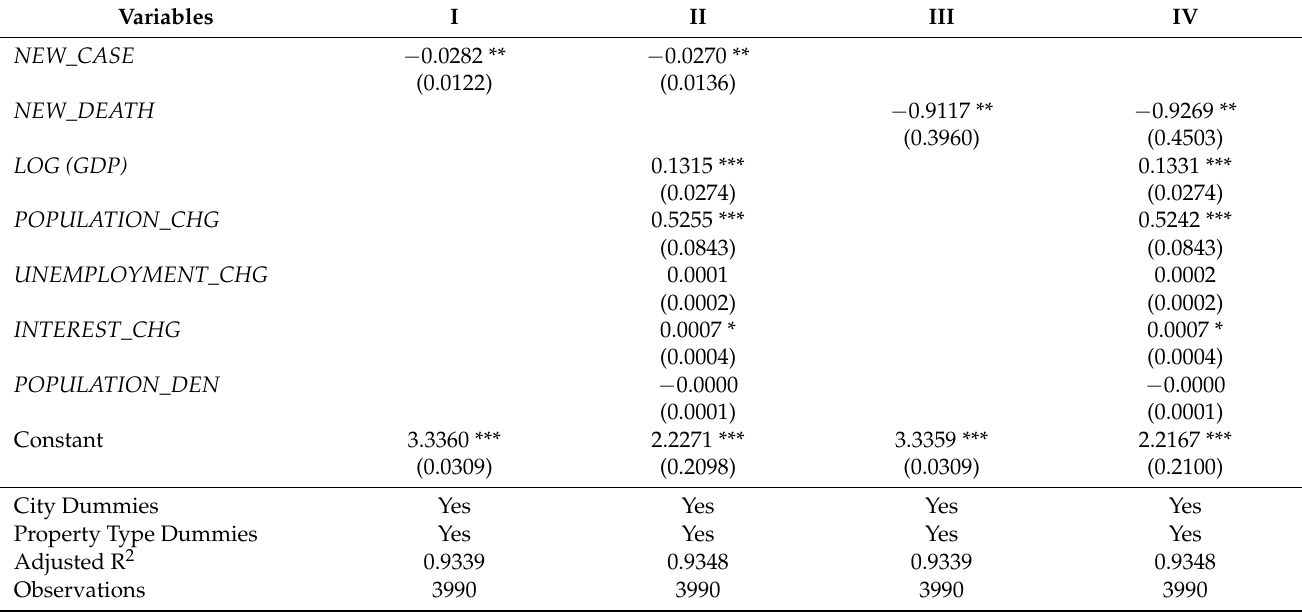
Table 10. Robustness Analysis on New Cases and Deaths. This table presents the OLS regression estimation results of testing the impact of the COVID-19 pandemic on commercial real estate rent. The dependent variable is LOG (RENT) , the natural logarithm of rent for the specific city and property type. The independent variables of interest are NEW_CASE , and NEW_DEATH , which represent the new COVID-19 confirmed cases and deaths of each quarter by country/jurisdiction, respectively. All variables are described in Appendix A. The standard errors are reported in parentheses. ***, **, and * denote significance of the t-statistics at the <1%, 5% and 10% levels,